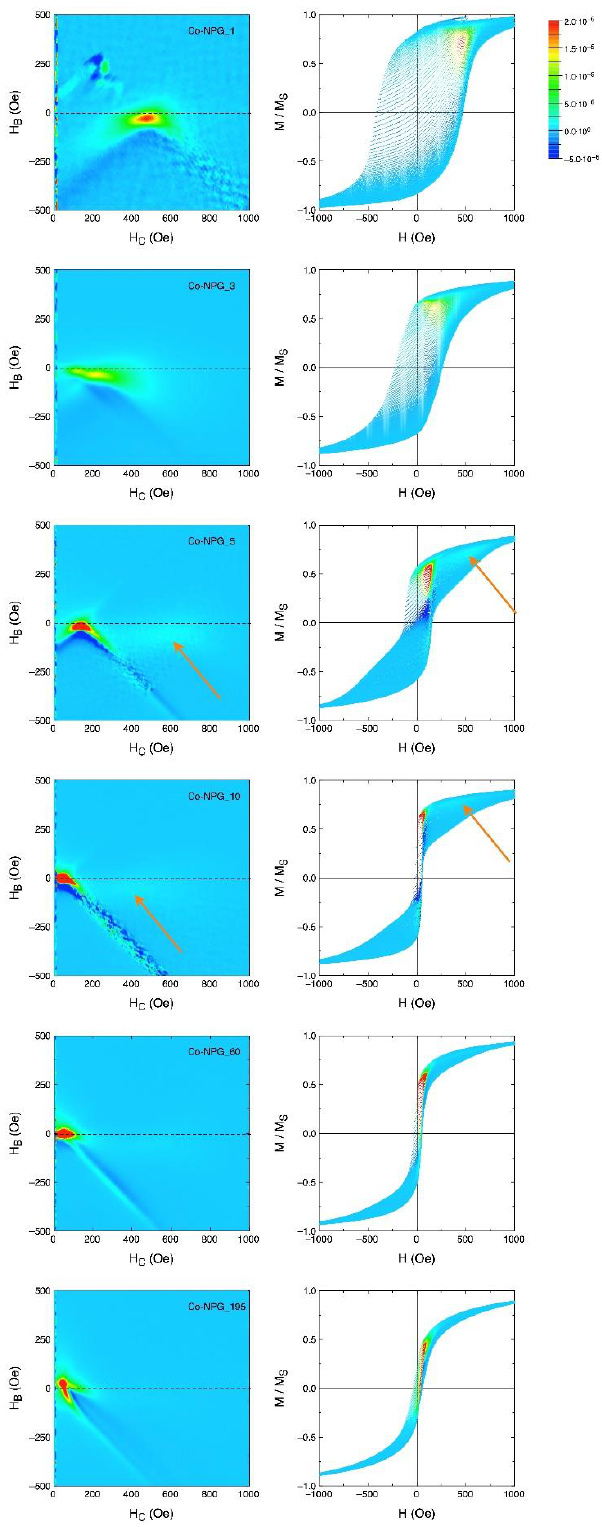
Figure 10. Left panels: FORC distribution in the (H B ,H C ) plane for all studied Co-NPG_X samples; right panels: subset of the measured reversal curves.